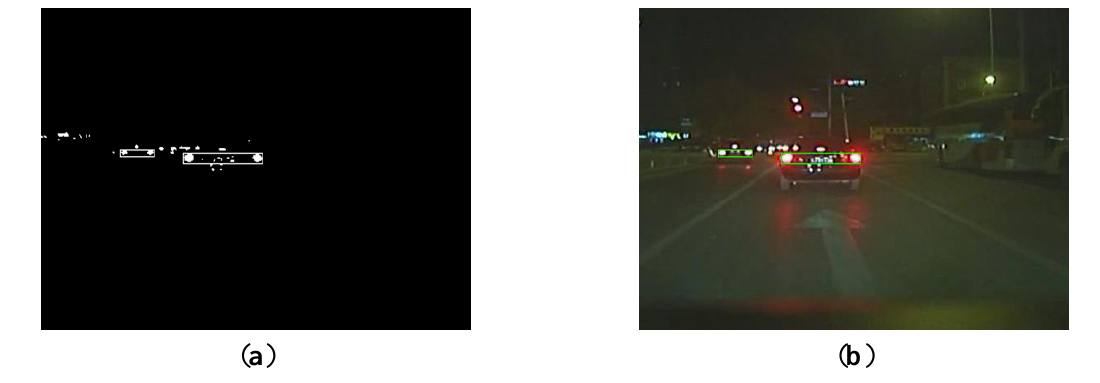
Figure 6. Results of vehicle detection based on taillight pairing and relevance analysis: ( a ) Vehicle detection result in binary image; ( b ) Vehicle detection result in color image.